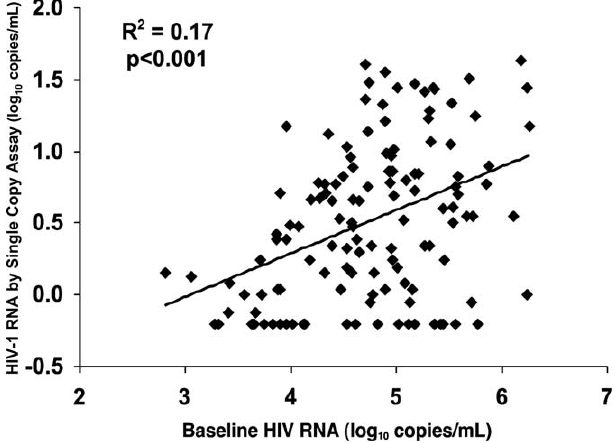
Figure 3. Correlation between Pretherapy and On-Therapy Viral RNA Levels Pretherapy and week 60 SCA values were determined for 130 patients from both the NFV and LPV/r arms in M98–863. Correlation coefficients for patients taking LPV/r and NFV regimens were similar.